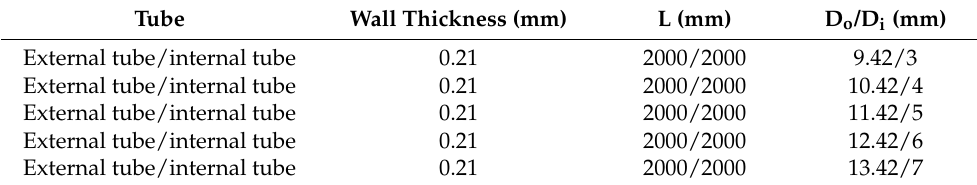
Table 1. The dimensions of the double-concentric